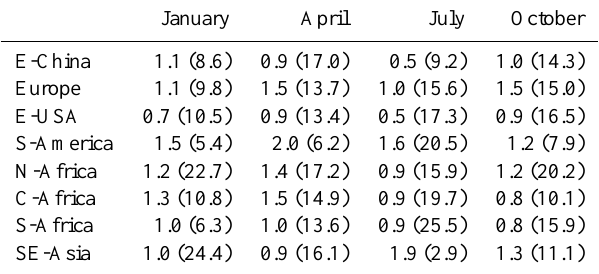
Table 6. The 15-day mean (16–30th of each month) and regional mean relative observation error for DOMINO v2. The relative error was estimated by dividing the mean observation error by the mean observation concentration for each super-observation. The mean number of OMI pixels (per day per 1 . 0 ◦ × 1 . 0 ◦ ) used for making the super-observation is shown in brackets. Note that during the calculation of the relative error, 0.1 × 10 15 molec . cm − 2 was added to both the denominator and the numerator to avoid the divergence caused by near-zero concentrations and to reduce the influence of remote site